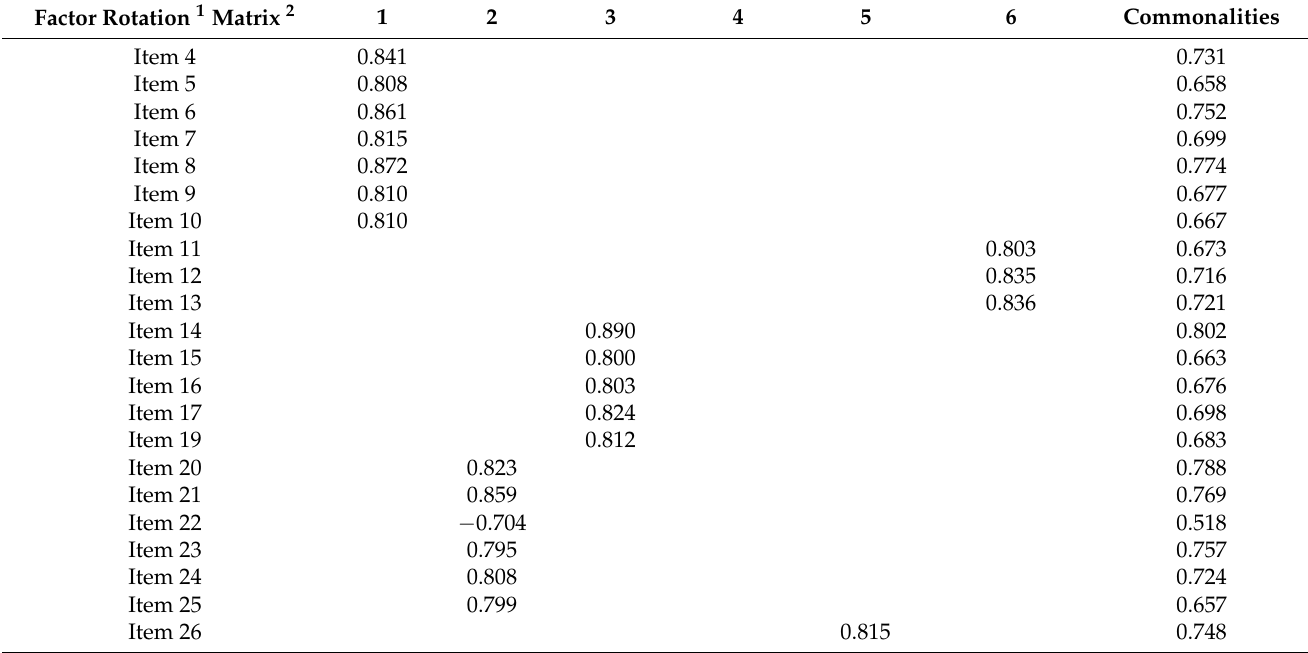
Table 3. The rotated matrix of factor analysis with commonalities for each